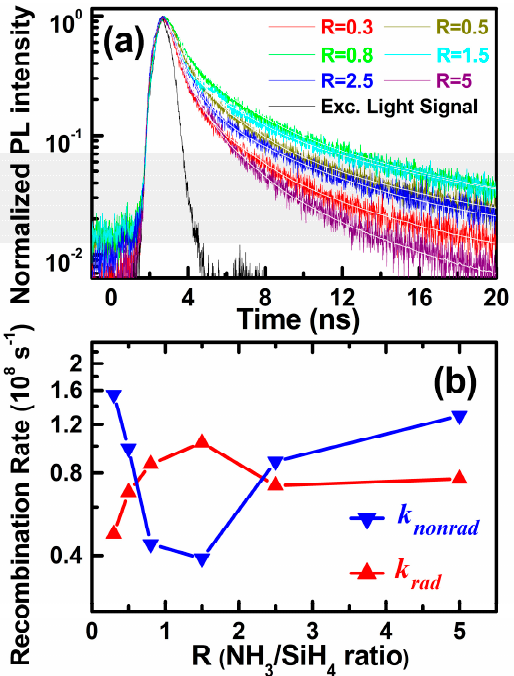
Figure 4. ( a ) ns-TRPL decay curves and the related simulations with different R values at RT. ( b ) The calculated k r (R) and k nr (R) of a-SiN x O y films vs. R.